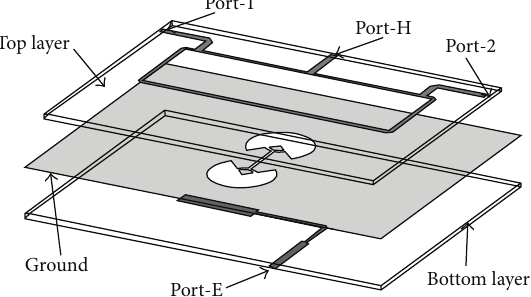
Figure 3: The explosive view of the magic-T.